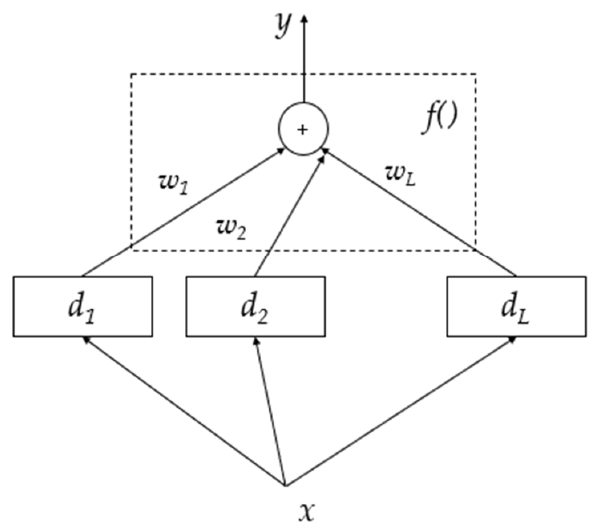
Figure 5. Combining base learners and their outputs [67].